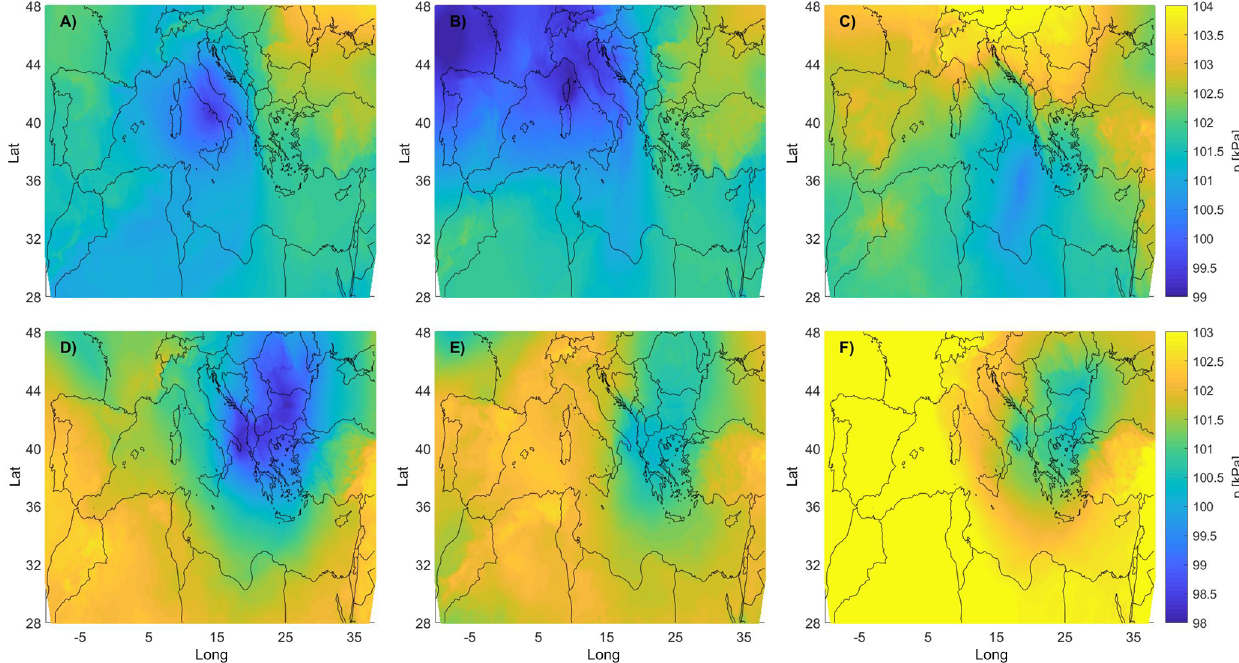
Figure 6. MSLP associated with the three highest POT events in Monopoli (B7). (a–c) WP#1 events; (d–f) WP#2 events. The storms are sorted from left to right in descending